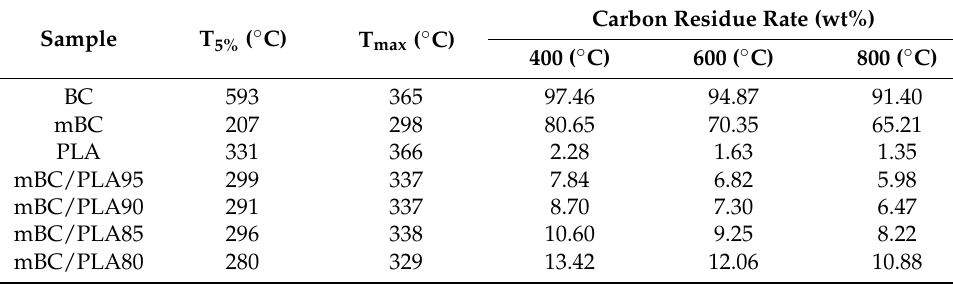
Table 3. Thermogravimetric analysis data of PLA